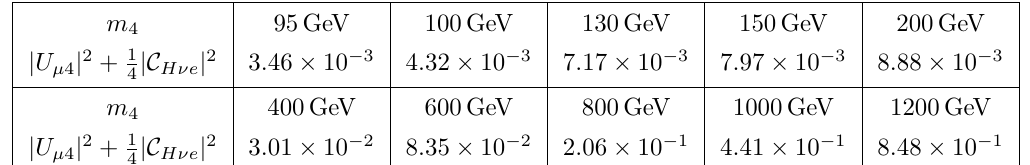
(cid:2) (cid:3) C Hνe and active-sterile neutrino mixing | U µ 4 | 4 µ